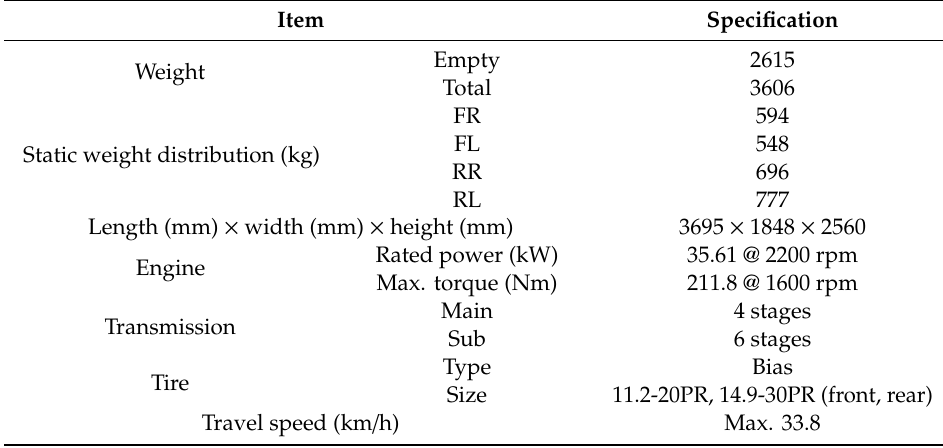
Table 1. Specifications of the agricultural tractor.